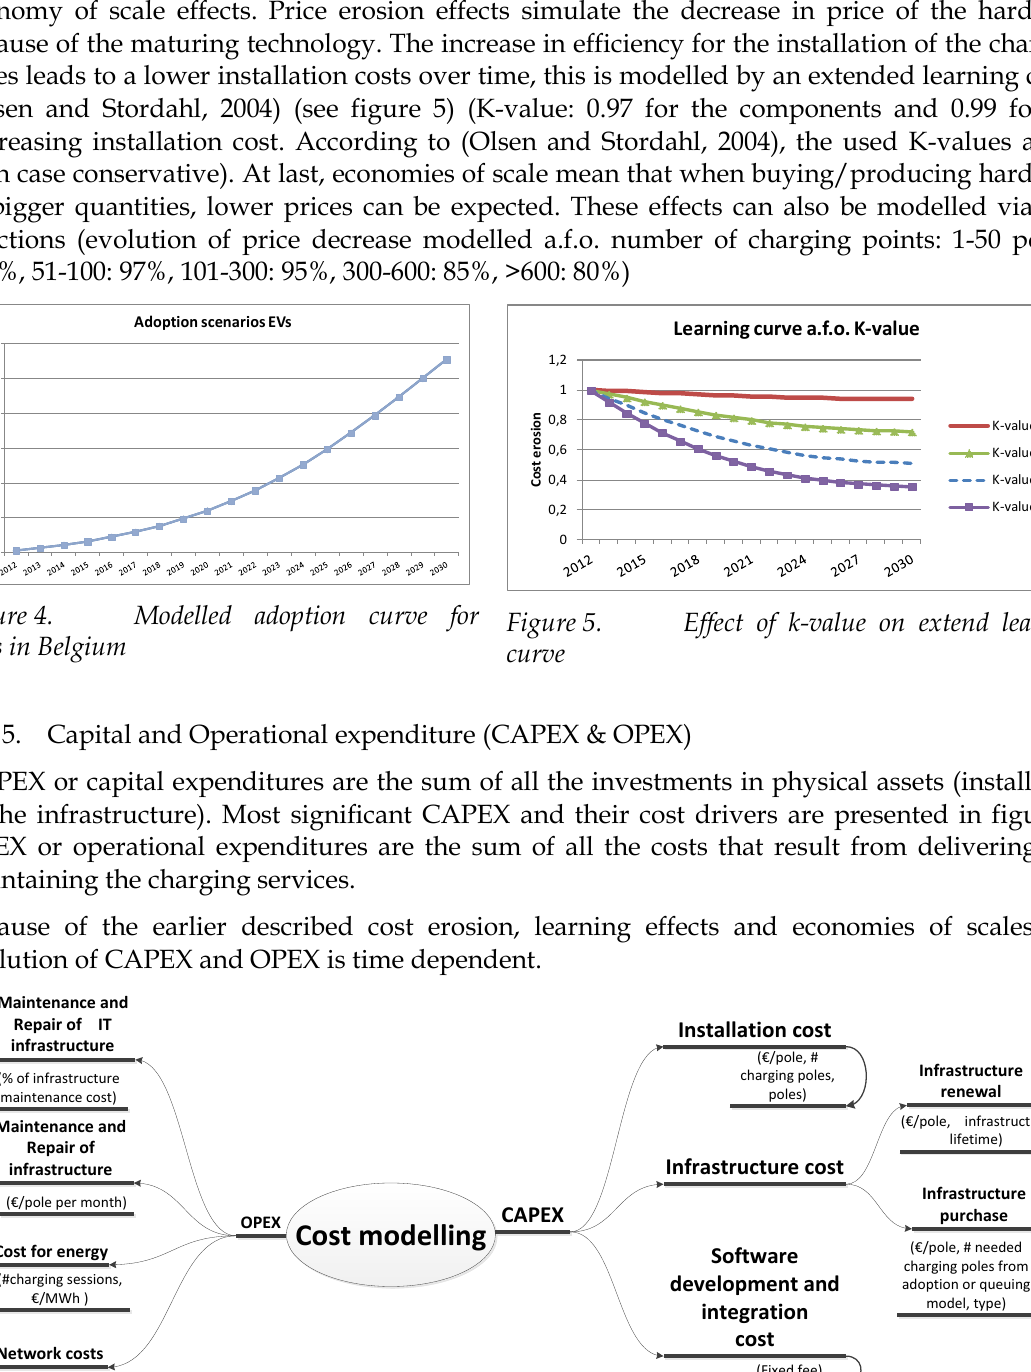
Learning curve a.f.o.